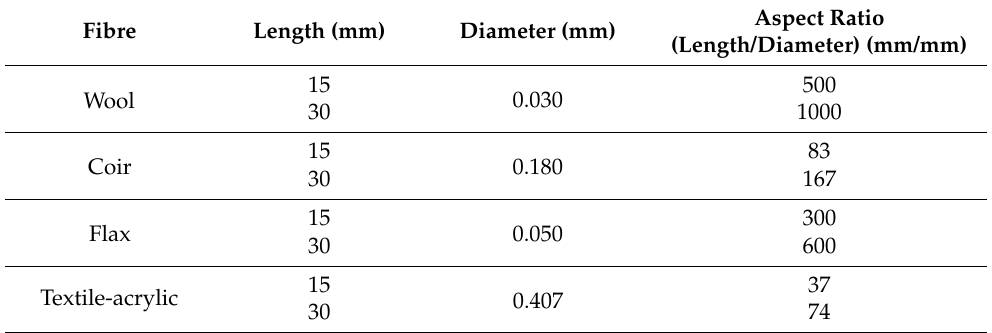
Table 1. Size of the fibres.